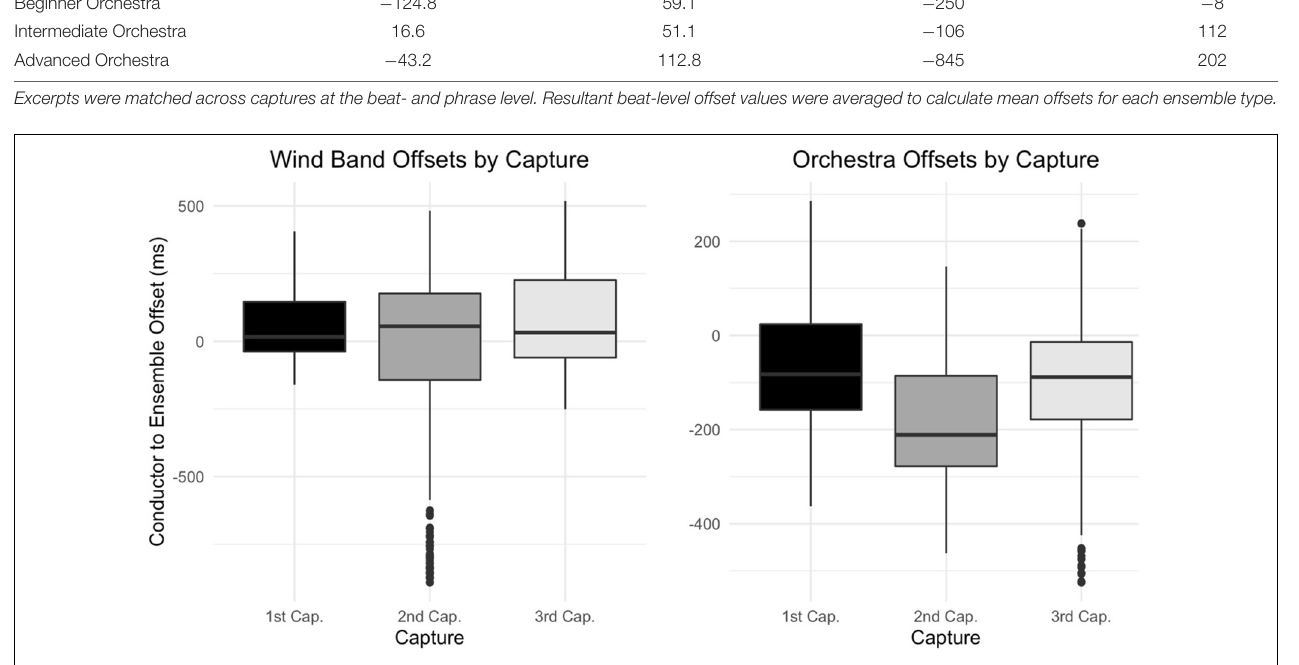
dynamic relationship between conductor and ensemble. While a precise description of the intraensemble relationship falls outside the scope of this paper, some noteworthy features do